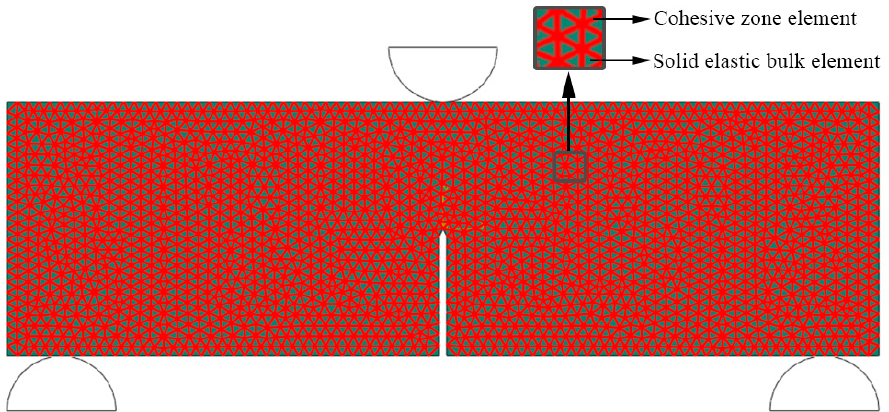
Figure 2. Geometric model for the numerical simulation.